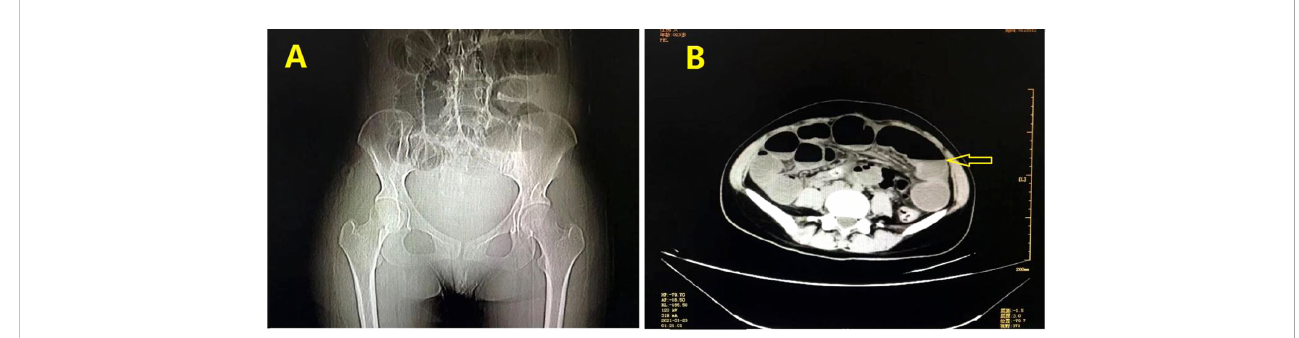
FIGURE 1 Imaging examination: (A) Digital radiology and CT scanning showed gas and fl uid accumulation in the small intestine and indicated intestinal obstruction. (B) Liquid, air and high intestinal tension were visible (lesion was marked with yellow